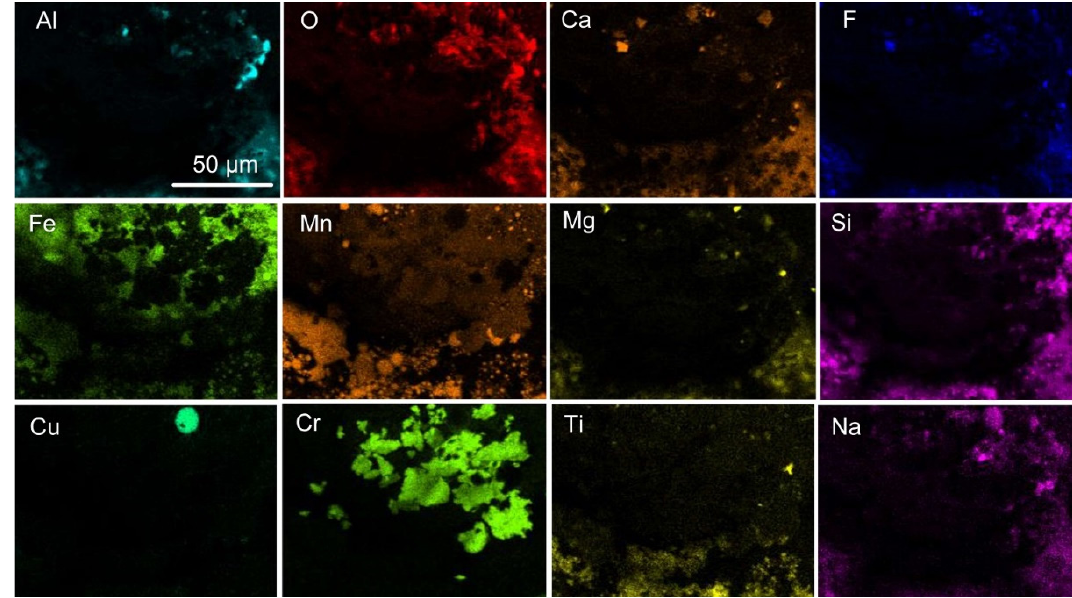
Figure 8. EDX map of marked area in Figure 6c: MP4 slag sample.